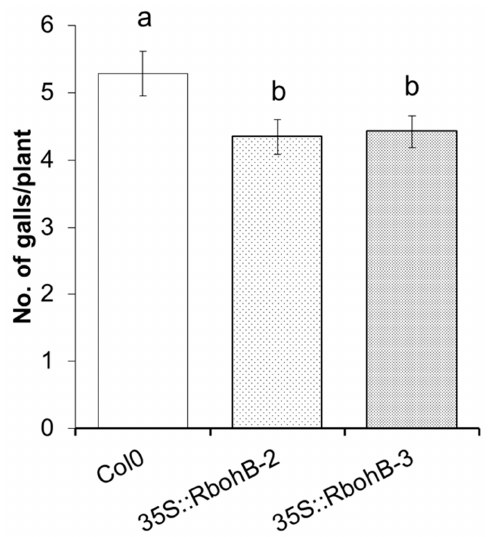
Figure 5. M. incognita resistance test. The resistance of two overexpression lines of RbohB was compared to wild type plants after infection with M. incognita . Number of galls per roots were counted at 15 dpi with different letters “a” and “b” indicating significant difference ( p < 0.05; ANOVA and LSD). The statistical significance was determined by three independent replicates. Values are means ± SE, n = 12.